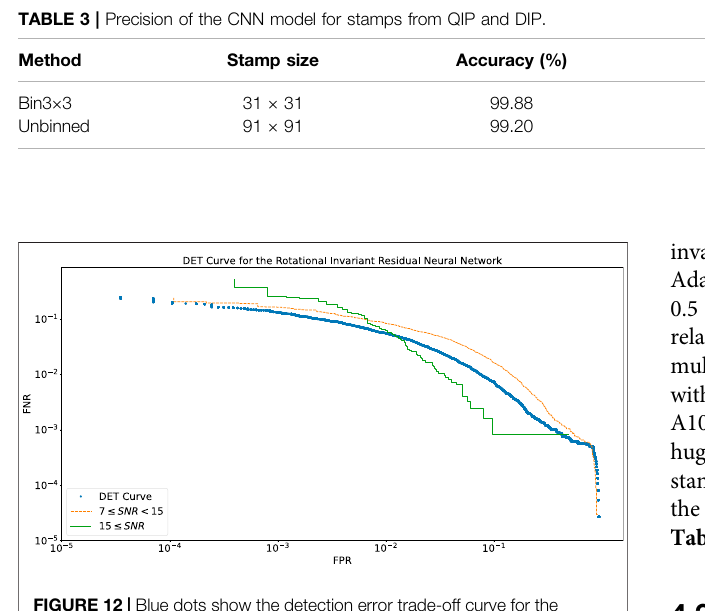
FIGURE 12 | Blue dots show the detection error trade-off curve for the stamps from 3 × 3 binned images. The green and orange curves show the DET curve for different signal-to-noise ratio groups. The x-axis is the false negative rate, and the y -axis is the false positive rate.